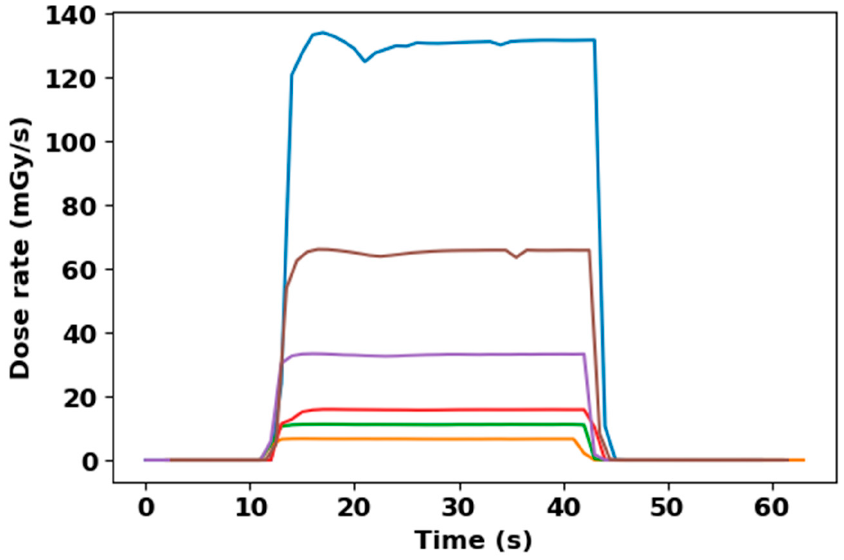
Figure 6. ORIATRON X ‐ ray beam dose rates measured with the PTW farmer 30013 reference do